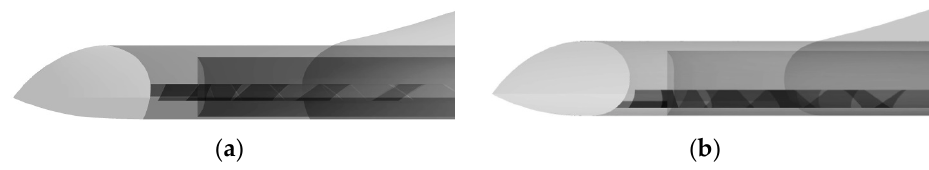
Figure 3. Transparent lateral view to show the duct inside structure and the shape of duct walls and the fan location. ( a ) The original configuration with arc duct walls; ( b ) The new configuration with semicircular duct walls.